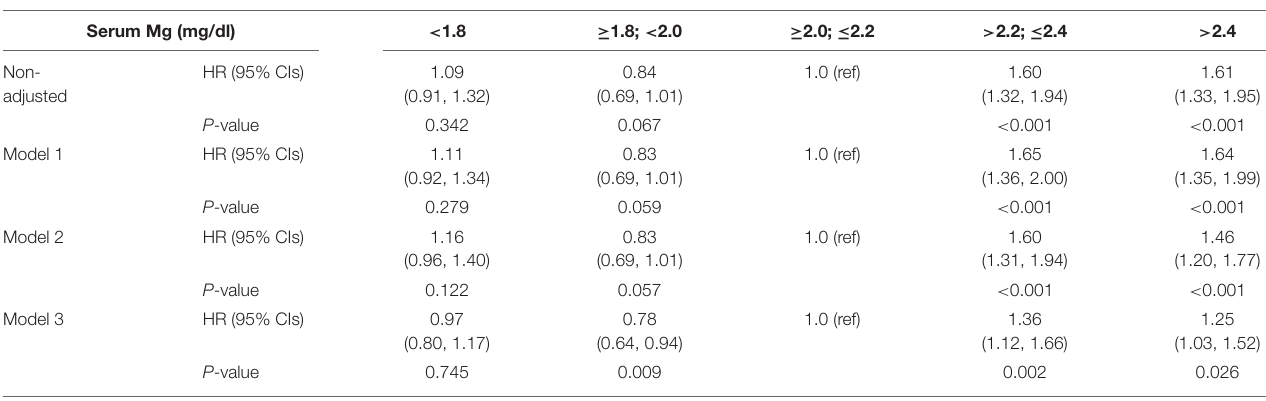
TABLE 3 | HRs (95% CIs) for mortality across groups of serum magnesium. Serum Mg (mg/dl) <